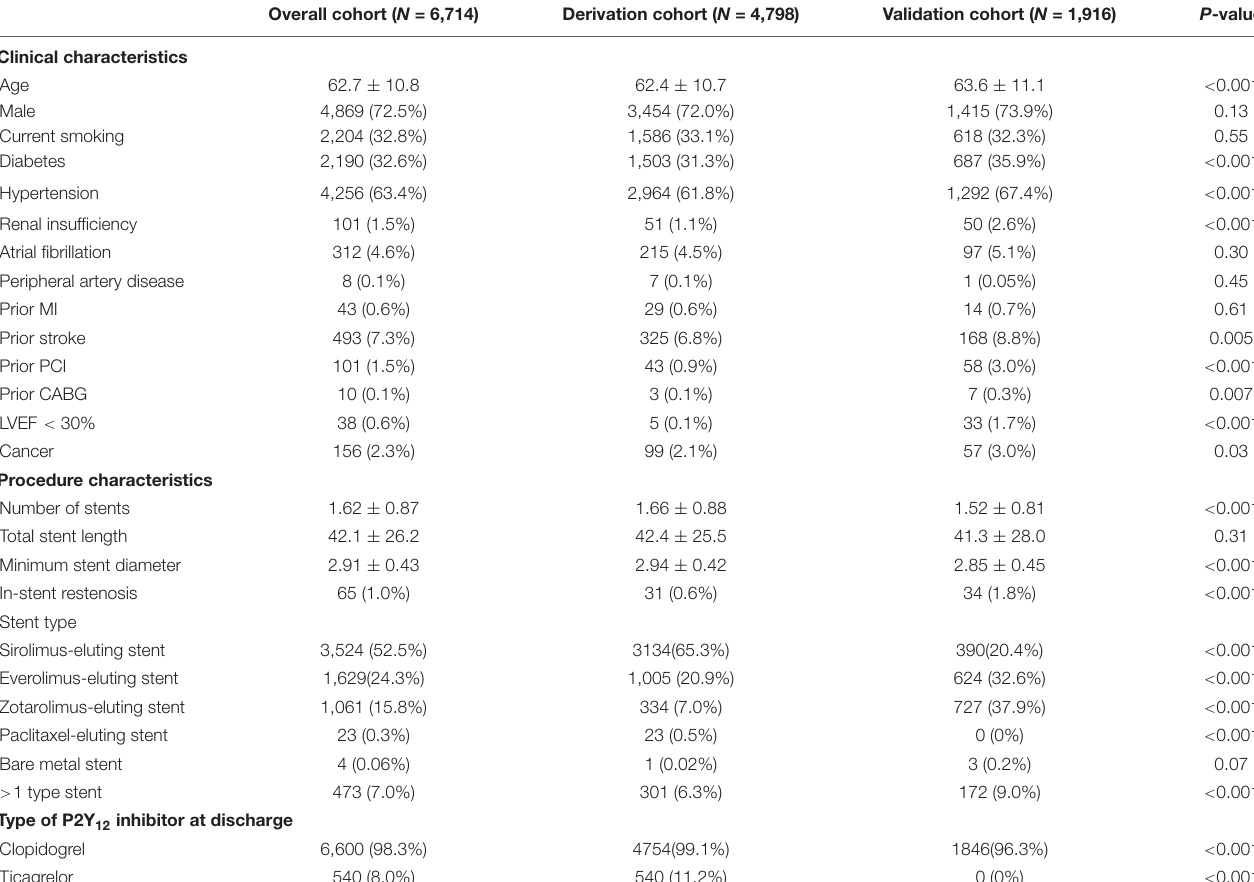
TABLE 1 | Baseline characteristics of PCI patients in the derivation, validation and overall cohort. Overall cohort ( N = 6,714) Derivation cohort ( N =